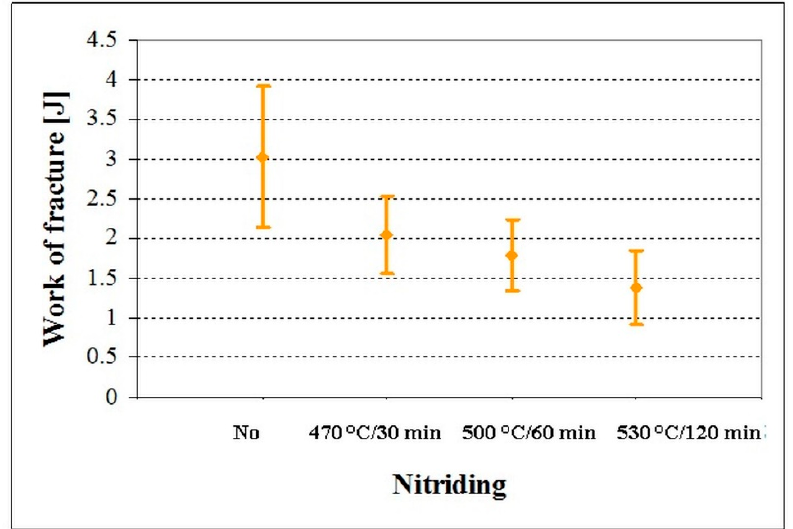
Figure 11. Work of fracture of non-nitrided and differently plasma nitrided specimens made of Vanadis 6 steel.